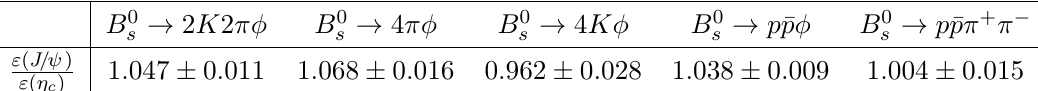
From simulation, after all requirements for B 0 ! 4 hK + K (cid:0) decays, a signi(cid:12)cant con- s tamination is expected from B 0 ! D + 3 h decays, where the D + decays to (cid:30)(cid:25) + and 3 h s s s is any combination of three charged kaons and pions. This background contribution has distributions similar to the signal in the 4 hK + K (cid:0) and K + K (cid:0) invariant-mass spectra, while its distribution in the 4 h invariant-mass spectrum is not expected to exhibit any peaking structure. In order to reduce this background contamination, the absolute di(cid:11)er- ence between the known value of the D + mass [13] and the reconstructed invariant mass s of the system formed by the combination of the (cid:30) candidate and any signal